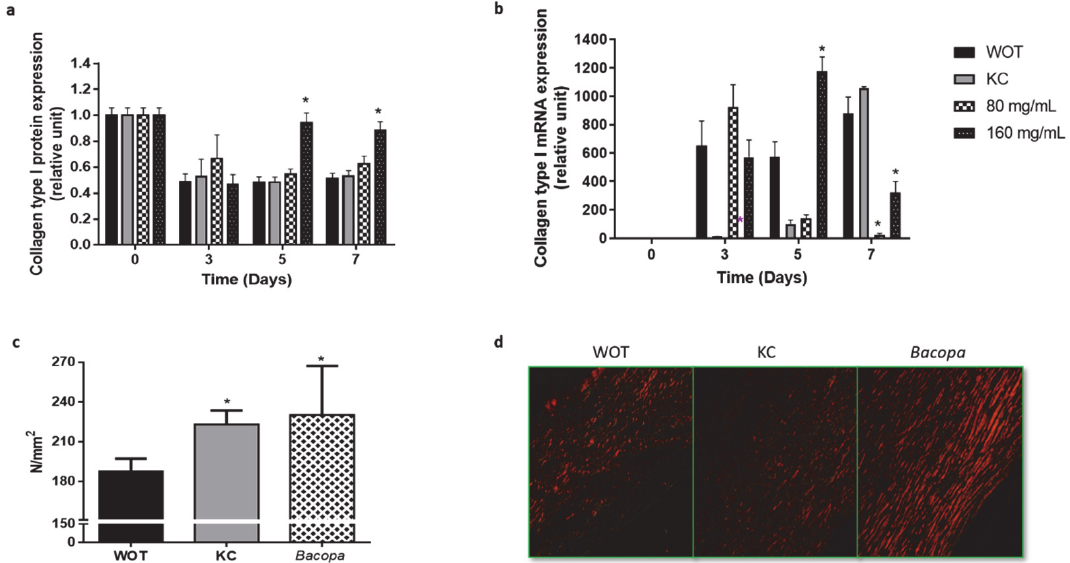
Figure 7. Collagen type I expression and mechanical effect and organization. ( a ) Collagen type I from wound tissues was analyzed by immunohistochemistry and by ( b ) qRT-PCR at different periods of time (0, 3, 5, and 7 days). ( c ) The tensile load applied in wounds was analyzed in scars from WOT, KC, and 160 mg/mL PB -treated groups after 24 days and ( d ) representative microphotographs of Picrosirius Red stain in scars from WOT, KC, and PB groups after 24 days of wound healing. Values are expressed as mean ± SEM of at least 6 animals per group; * p < 0.05 versus WOT as indicated by analysis of variance (ANOVA) and post hoc Tukey’s test.